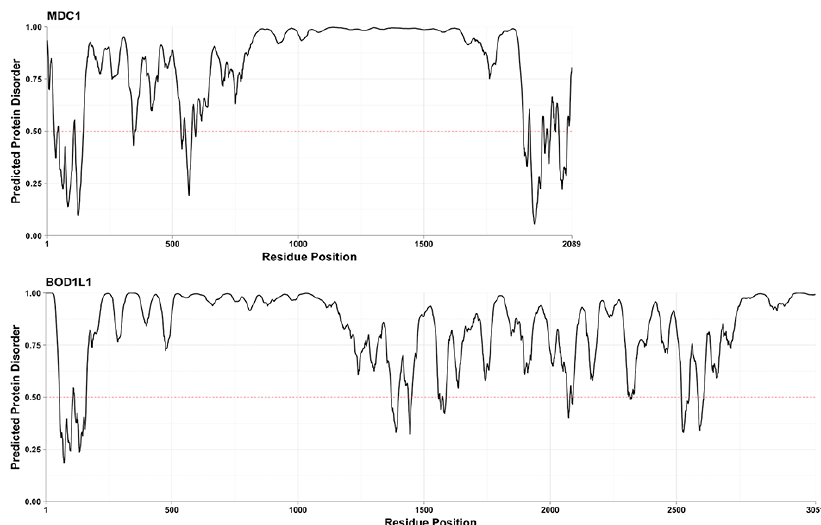
Figure 4. Examples of proteins with long IDRs. Proteins that are reproducibly found by the VSL2b, PV2 and PrDOS predictors in the set of 14 proteins with the longest predicted IDRs (red text in Figure 3A) are shown. The residue-by-residue intrinsic disorder score (VSL2b) is plotted as a function of residue number throughout the length of the respective proteins. The horizontal gridline at a score of 0.5 distinguishes regions predicted to be ordered (<0.5) or intrinsically disordered